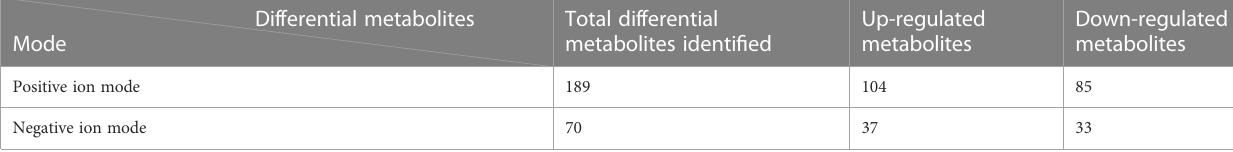
TABLE 3 Differential metabolites identi fi ed in the positive and negative ion modes in the caries-active group compared to the caries-free